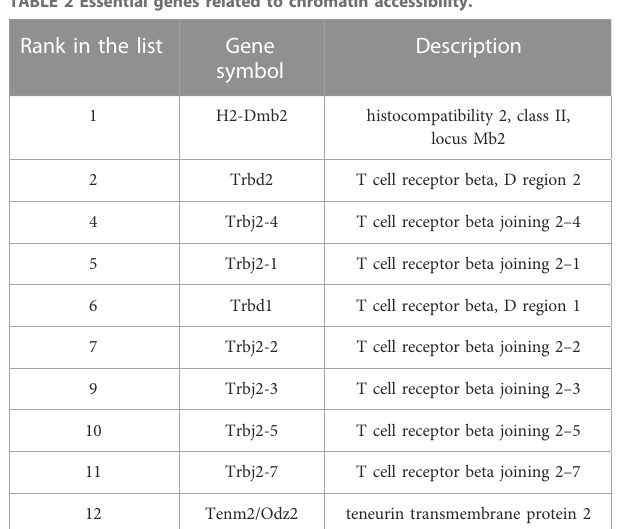
TABLE 2 Essential genes related to chromatin